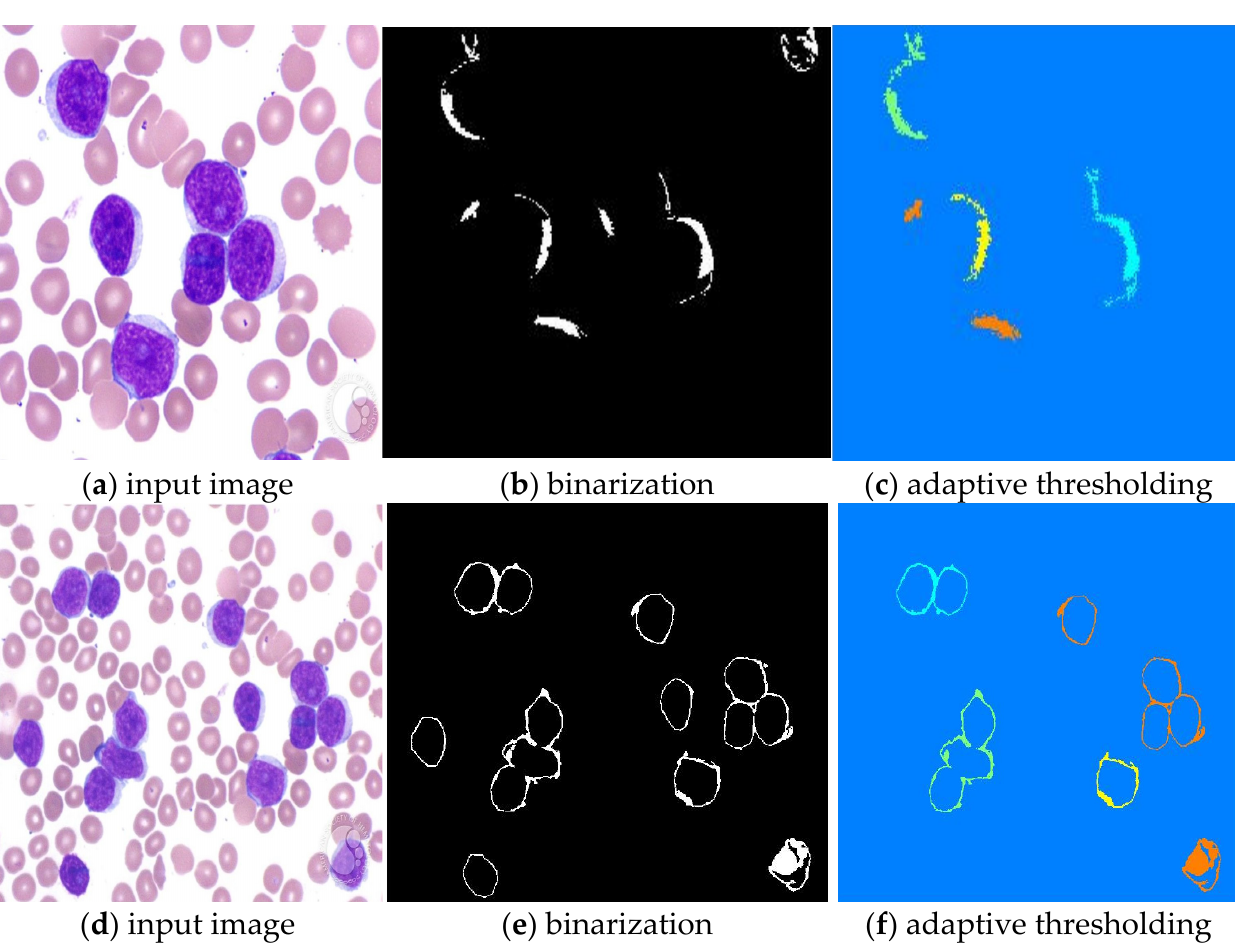
Table 2. Simulation of parameters.